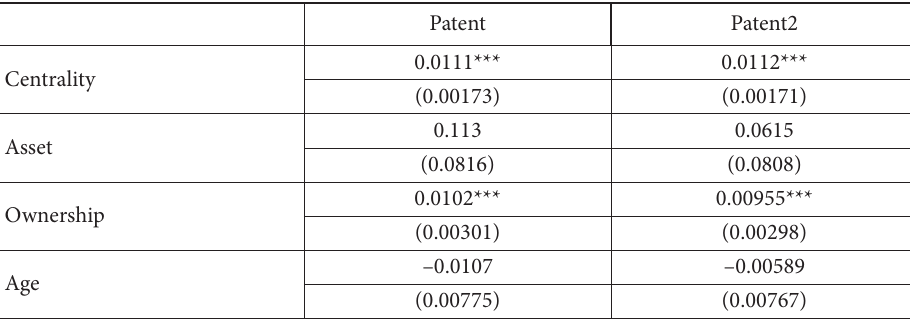
Table 5. Robustness